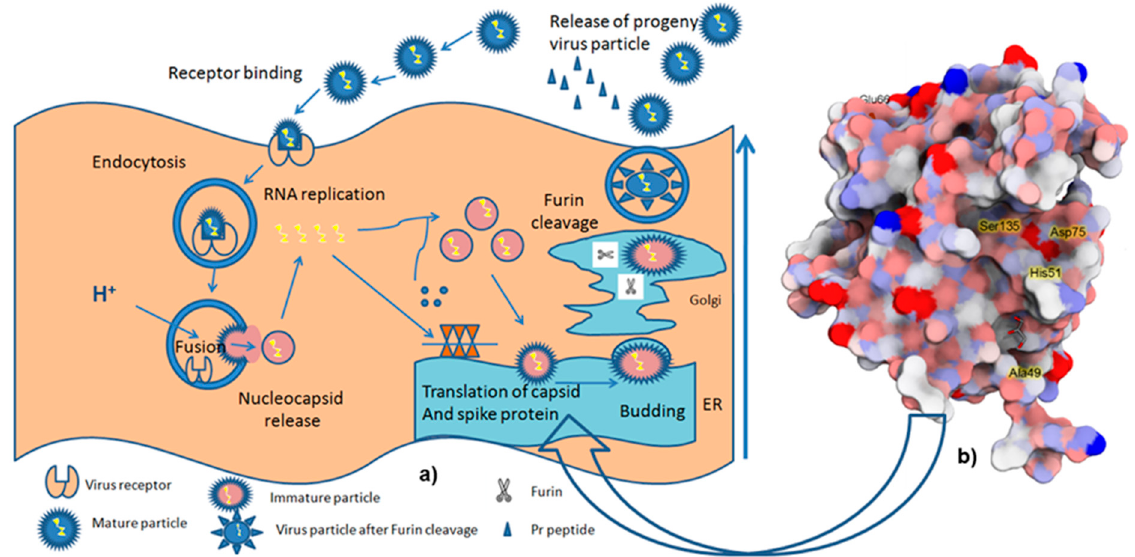
Figure 3. Illustration of ( a ) the life cycle of dengue virus (modified from [108]), and ( b ) the DENV2 NS2B / NS3 protease, retrieved from PDB 2FOM, processing polyprotein cleavages either co-translationally or post-translationally [109].